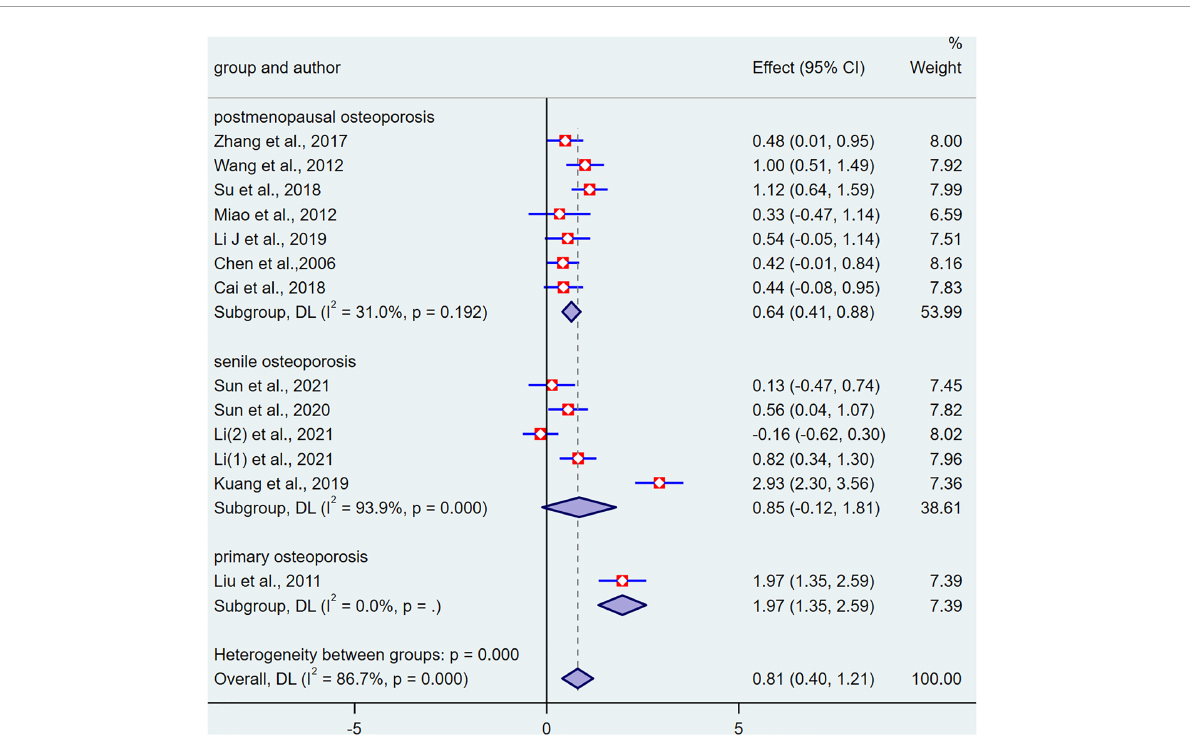
FIGURE3 The bone mineral density (BMD) results of all participants for three subgroups: the control group vs. the intervention